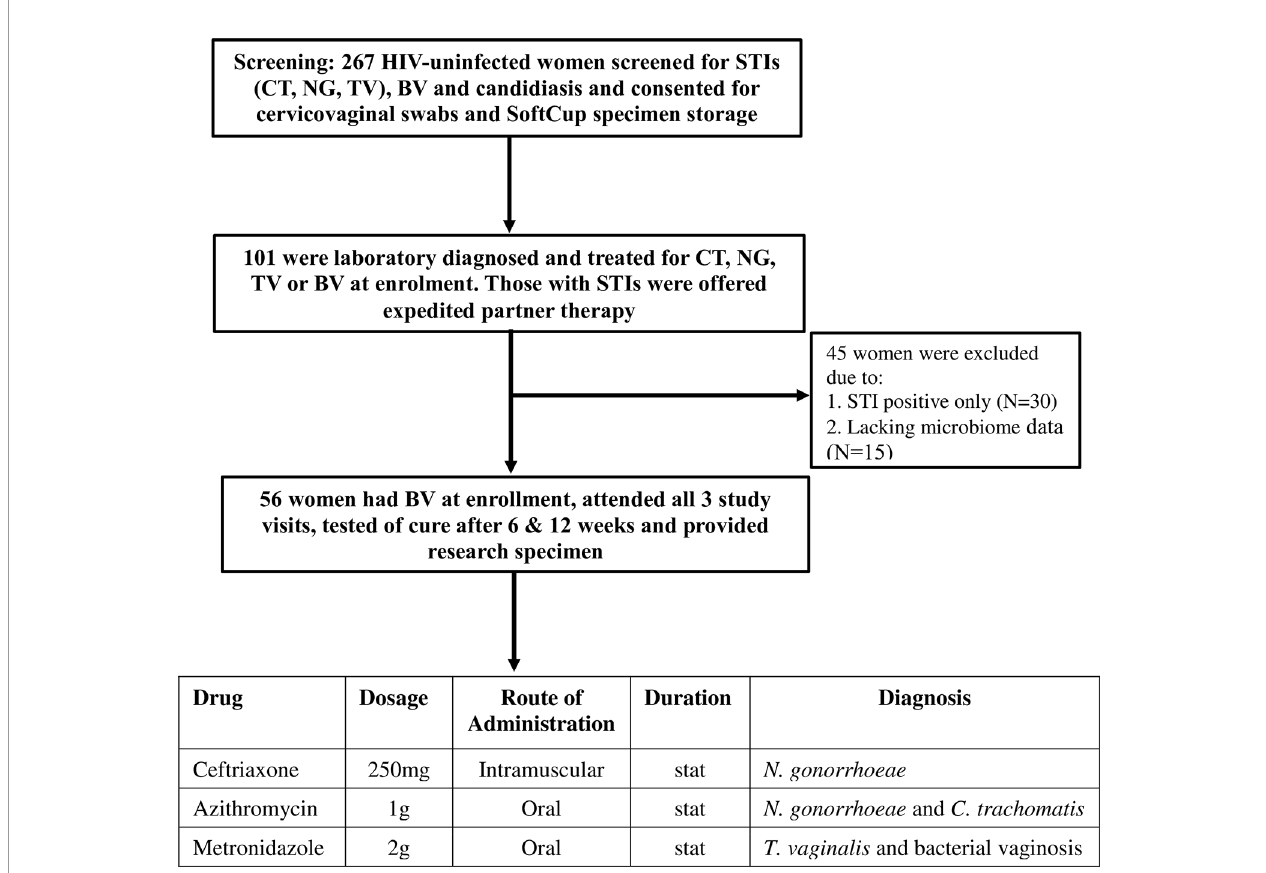
FIGURE 1 | Screening, enrolment and follow-up of the study participants in the CAPRISA 083 cohort study. Consenting women underwent bacterial vaginosis (BV) and Candida screening and point-of-care (POC) testing for sexually transmitted infections (STI): chlamydia (CT), gonorrhoea (NG) or Trichomoniasis (TV). Women diagnosed with Nugent-BV and any STI were treated, tested for cure at follow-up visits (6 and 12 weeks) and offered expedited partner therapy to deliver to their partners. Mucosal samples were collected at all visits. Women diagnosed with STIs only and/or who did not have vaginal microbiome data were excluded from the study and only those who attended all 3 visits and provided specimens were